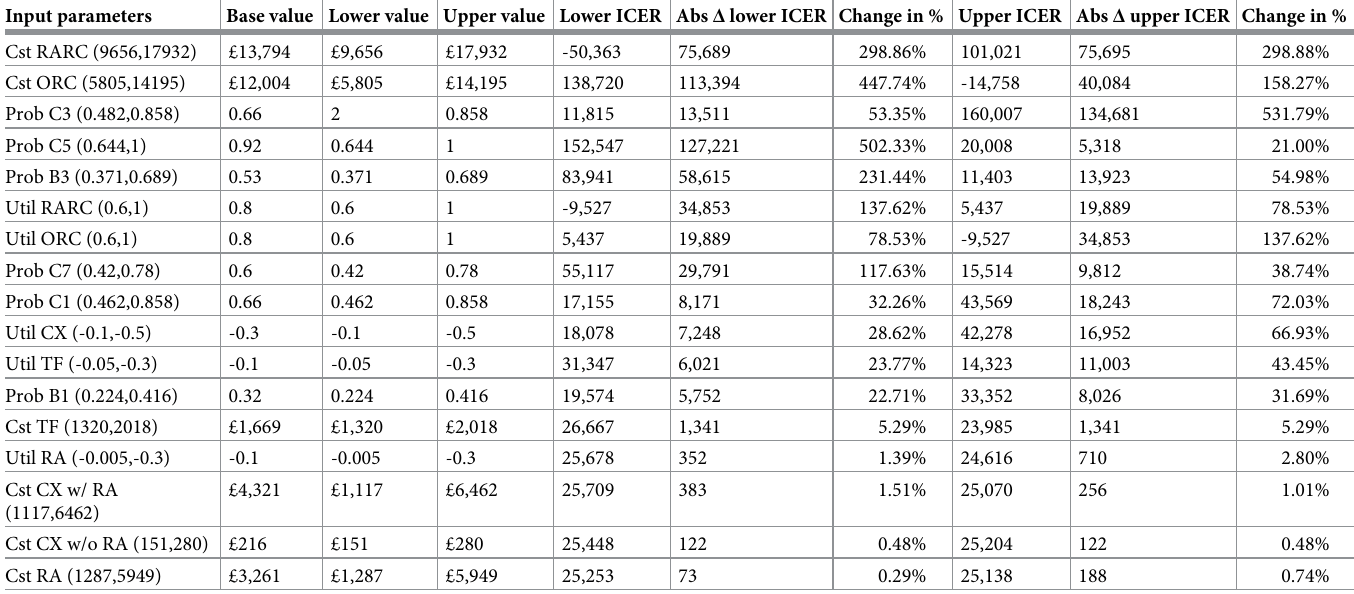
Table 3. Multiple univariate sensitivity analysis showing changes of the ICER in relation to variation of the base values of input parameters. Input